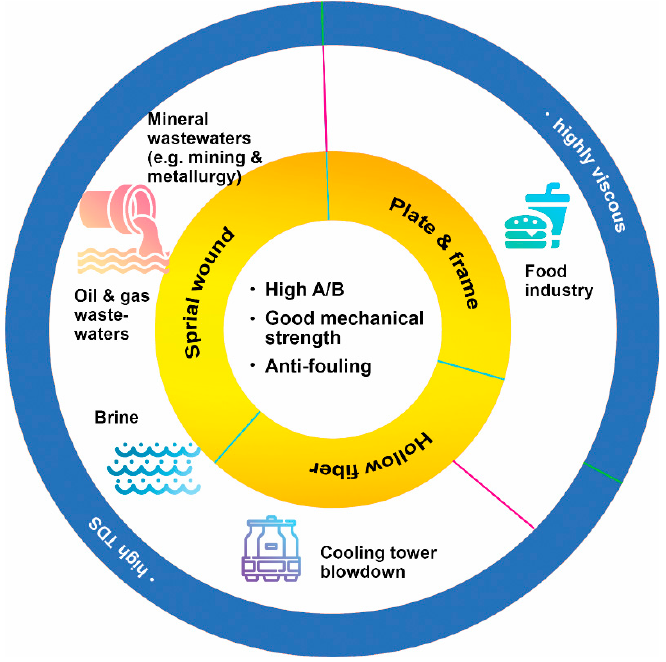
Figure 5. Selection of suitable FO membrane modules for different FO